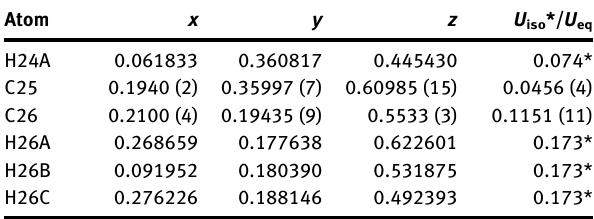
Table  : Fractional atomic coordinates and isotropic or equivalent isotropic displacement parameters (Å 